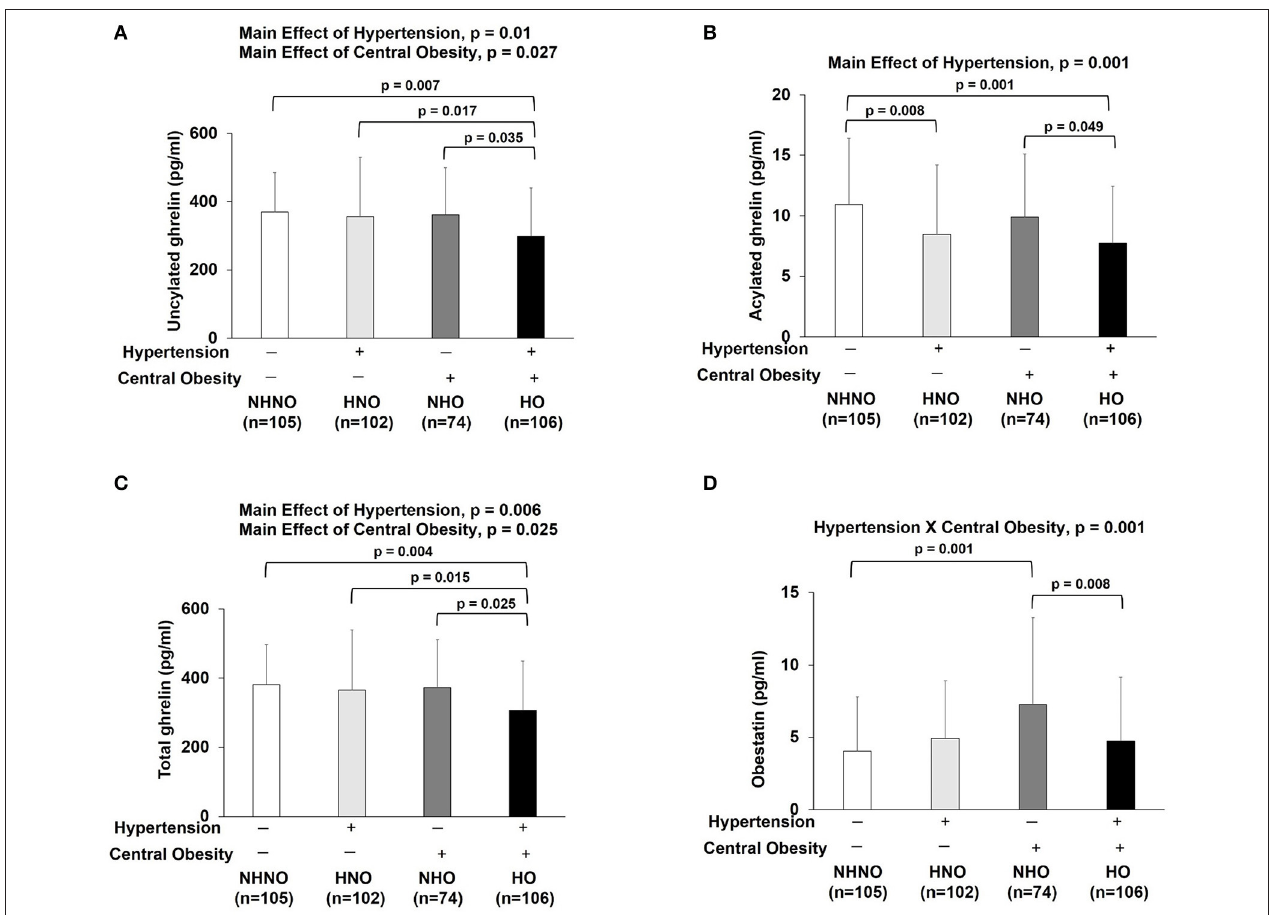
FIGURE 4 | Ghrelin gene products: unacylated ghrelin, acylated ghrelin, total ghrelin and obestatin. There were significant main effects of hypertension and central obesity on unacylated ghrelin and total ghrelin (A,C) . There was significant main effect of hypertension on acylated ghrelin (B) . Unacylated ghrelin, acylated ghrelin and total ghrelin were decreased in subjects with hypertension and central obesity (A–C) . Acylated ghrelin also decreased in subjects with hypertension (B) . Obestatin revealed the interaction of hypertension with central obesity (D) . Obestatin increased in subjects with only central obesity but not in subjects with hypertension and central obesity (D) . The main effects of hypertension and central obesity and the interaction of hypertension with central obesity were analyzed with generalized estimating equations. Significance level was set at p <